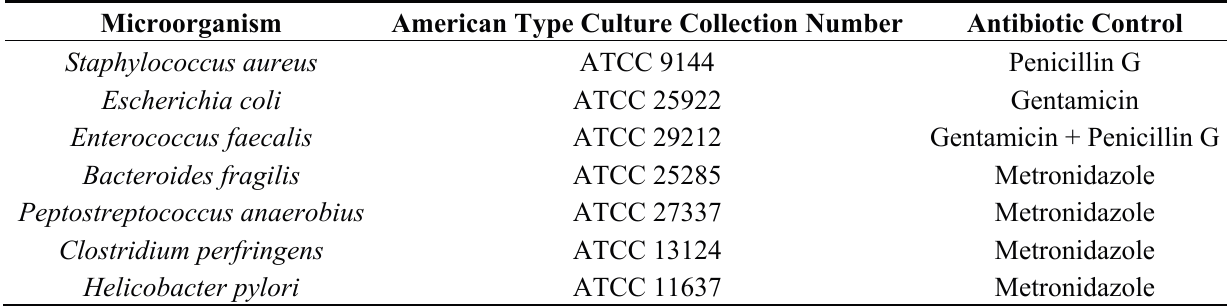
Table 1. Microorganisms and antibiotic controls used in minimum inhibitory and minimum bactericidal concentration determinations.